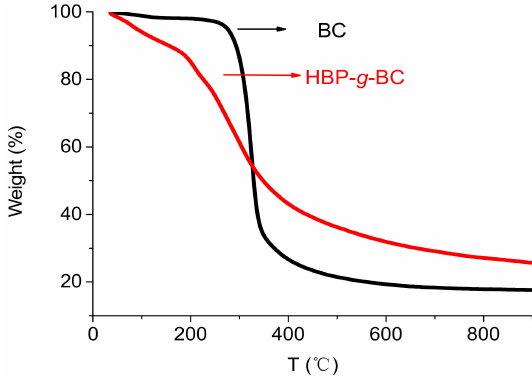
Figure 3. TGA curves of BC and HBP- g